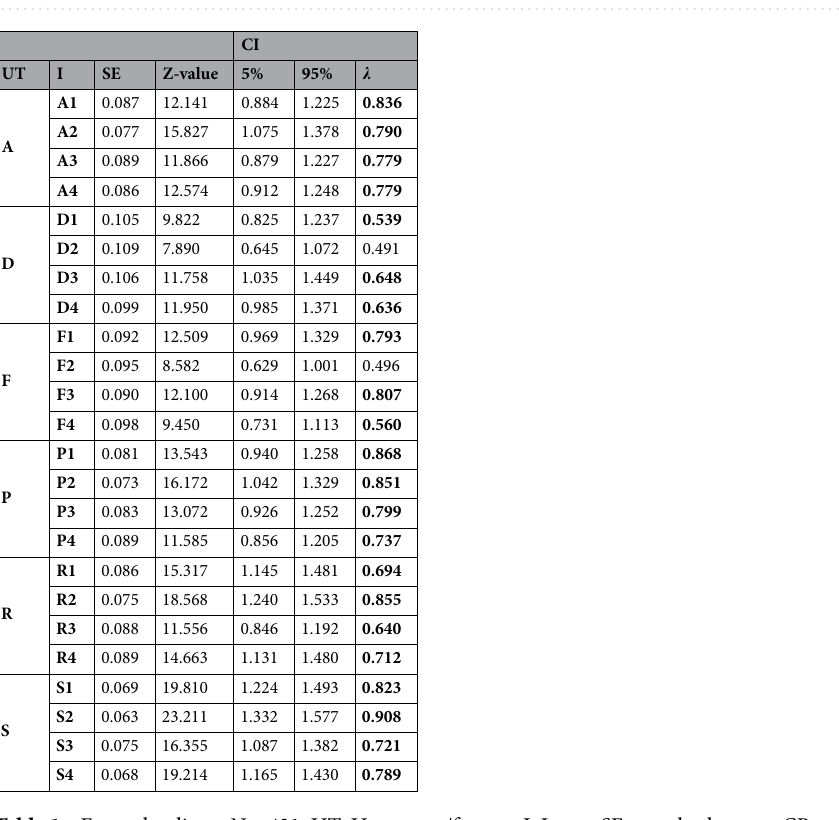
Figure 1. Path model (adapted from Tondello et al . 9 ). The ellipses represent the factors and the rectangles represent the items of the scale.